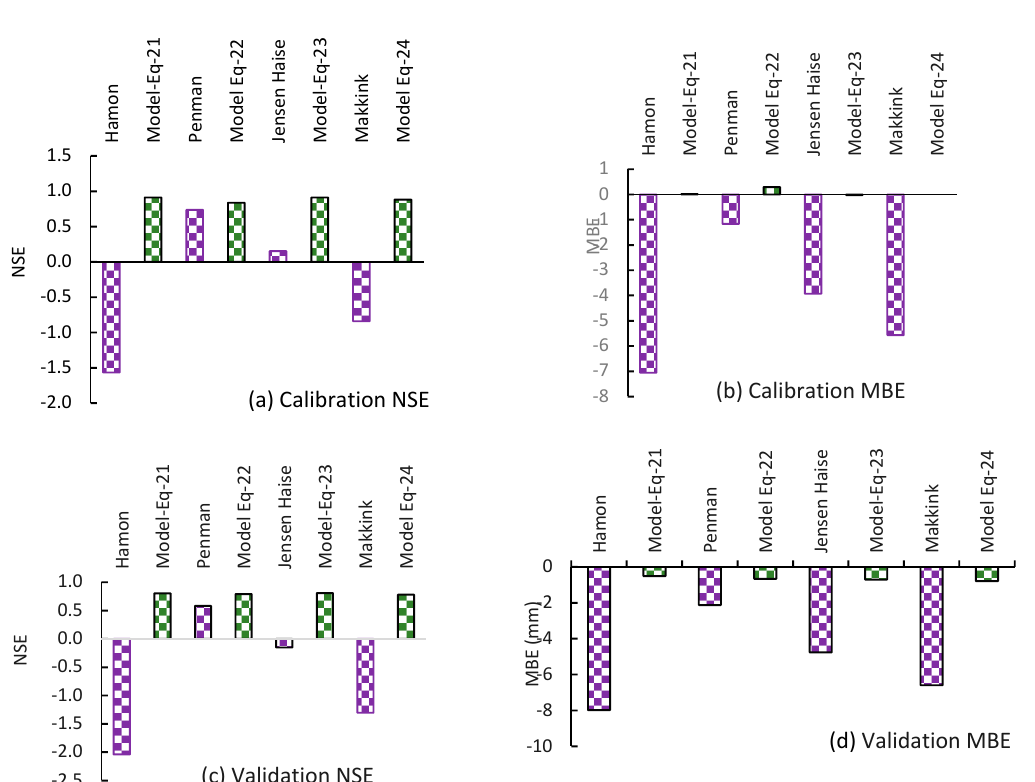
Figure 7. Comparison of the observed and simulated values of evaporation obtained from the four developed equations: ( a ) Calibration; and ( b ) Validation.